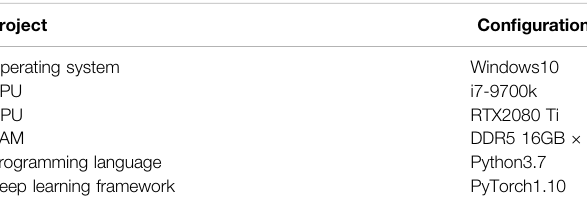
TABLE 2 | Experimental environment con fi